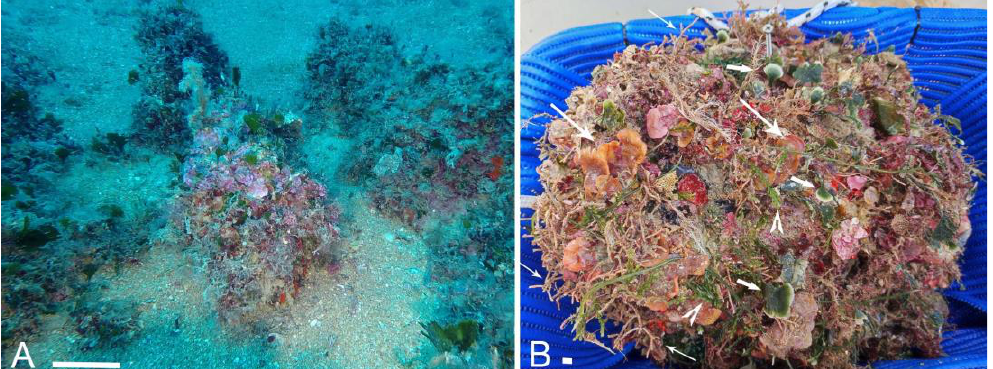
Figure 2. ( A ) Image from the ROV_290621_06 in a setting similar to that from where the coralligen- ous build-up was collected. ( B ) The build-up E soon after recovery, showing the dense canopy of algae and interspersed colonies of the bryozoan Margaretta cereoides . Arrow heads: Caulerpa cylindracea ; Stout arrows: Flabellia petiolata ; Big slender arrows: Peyssonnelia rubra ; Small slender arrows: Margaretta cereoides . Scale bars = 10 cm.